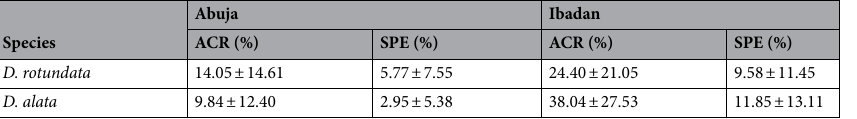
Table 4. Pollination success across IITA breeding sites (Ibadan vs. Abuja) for D. alata and D. rotundata. ACR = average crossability rate, SPE = seed production efficiency. ACR and SPE are presented by means ± standard deviation.